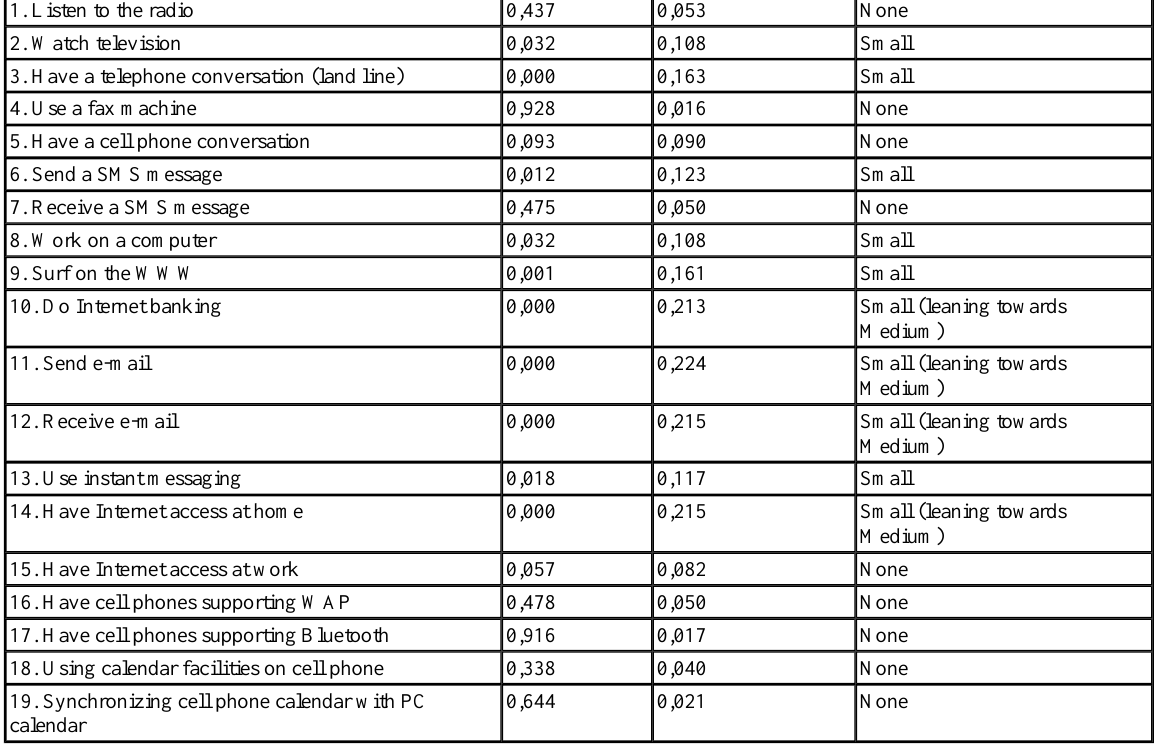
Section B: Information and communication media and technology The results of question 11, as depicted in Figure 8, relating to the frequency of use of specific ICTs, showed some interesting usage patterns among the respondents. A surprising majority (76,3%) of the respondents never used Instant Messaging as a means to transmit information, preferring the use of electronic mail on a daily basis. From the total number of respondents, 68,6% used e-mail to send information on a daily basis, while 14,2% used it to send information at least every two to four days (i.e. a total of 82,8%). Of the respondents, 71,3% used e-mail daily to receive information, while 14,2% used it at least every two to four days to receive information (i.e. a total of 85,5%). The most popular ICTs to be used on a daily basis by respondents